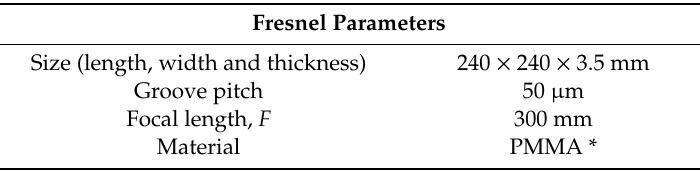
Table 1. Fresnel lens technical specification from DiYPRO Co., Ltd.